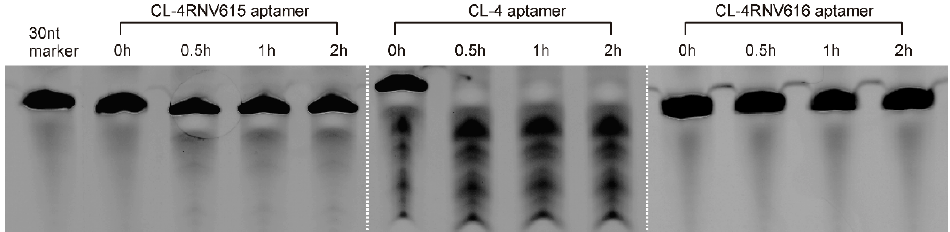
Figure 3. Evaluation of the stability of aptamers in 90% human serum. After incubation, samples were separated on a 20% Urea-PAGE denaturing gel, with a 30nt RNA sequence as the loading control. 2.3. CL-4RNV616 Aptamer Specifically Recognized EGFR Protein in Human Cancer Cells